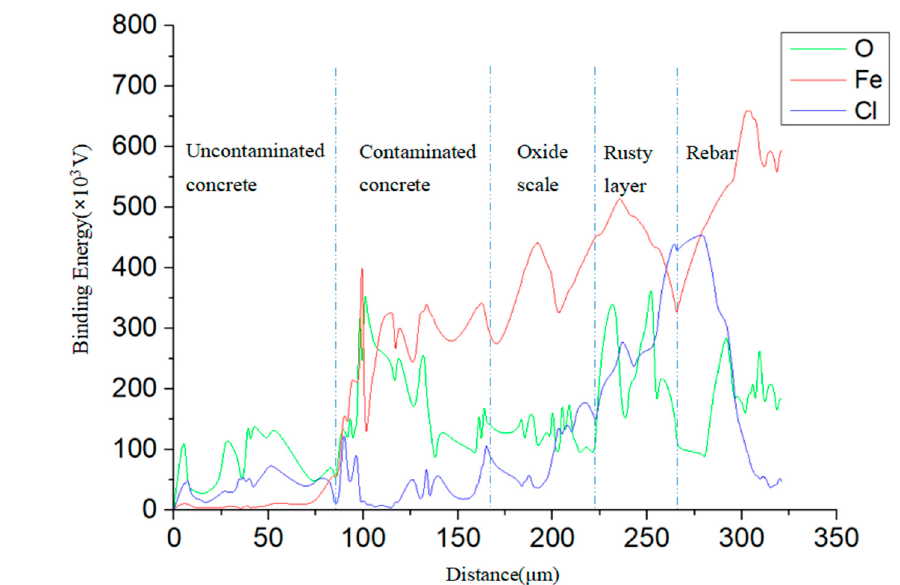
Figure 12. Distribution of corrosion products on the reinforced concrete interface. ( a ) SEM image and energy spectrum analysis line of the reinforced concrete interface, ( b ) binding-energy distribution of elements at the reinforced concrete interface.